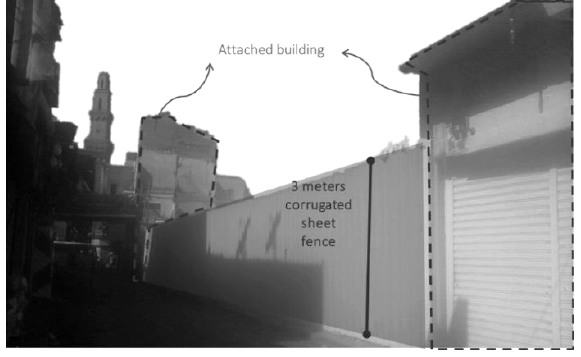
Figure 14. The fence and the adjacent buildings